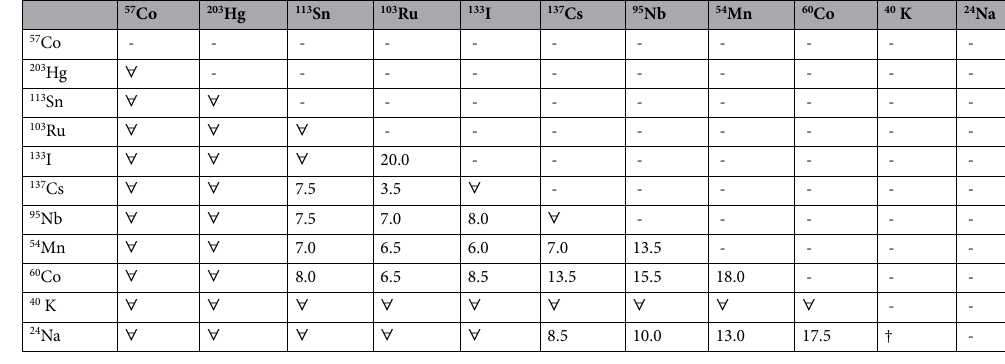
Table 3. Lower limit of simultaneously identified relative distances of gamma sources by considering equal activities (considering branching ratios) from gamma finder (lower energy source is fixed in distance of 2.0 m). “ ∀ ” means no matter where S 1 ( E 1 > E 2 ) is located, if S 2 is located in distance of 2.0 m from detector, it will be recognizable and “†” indicates that S